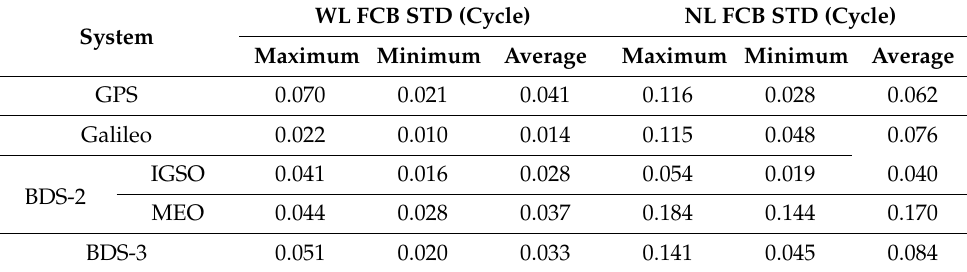
Table 4. Daily STD statistical results of GPS/Galileo/BDS-2/BDS-3 WL and NL FCB.